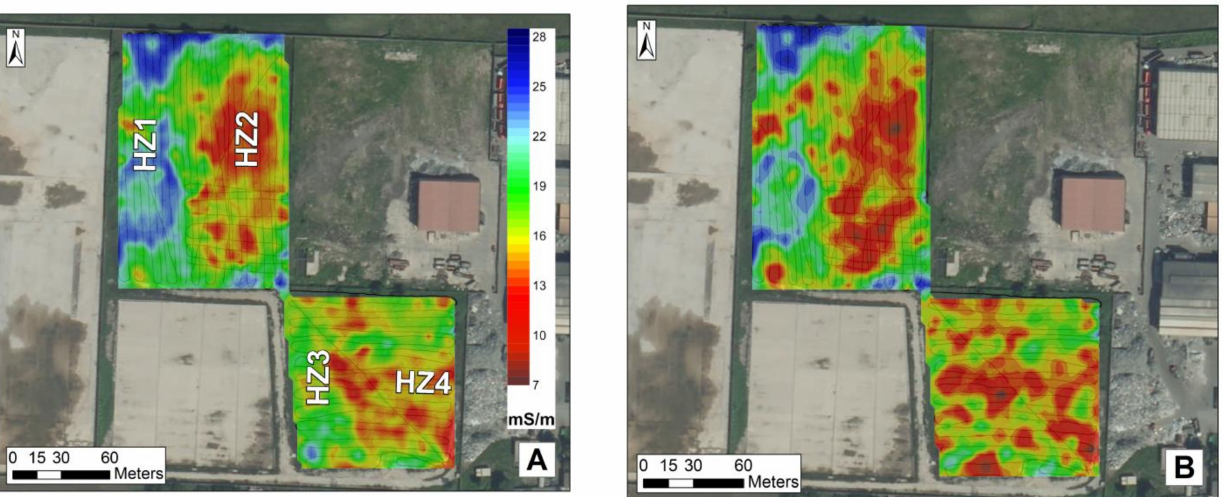
Figure 4. ECa maps (in mS/m) obtained from the PROFILER survey at ( A ) 15 KHz and ( B ) 7